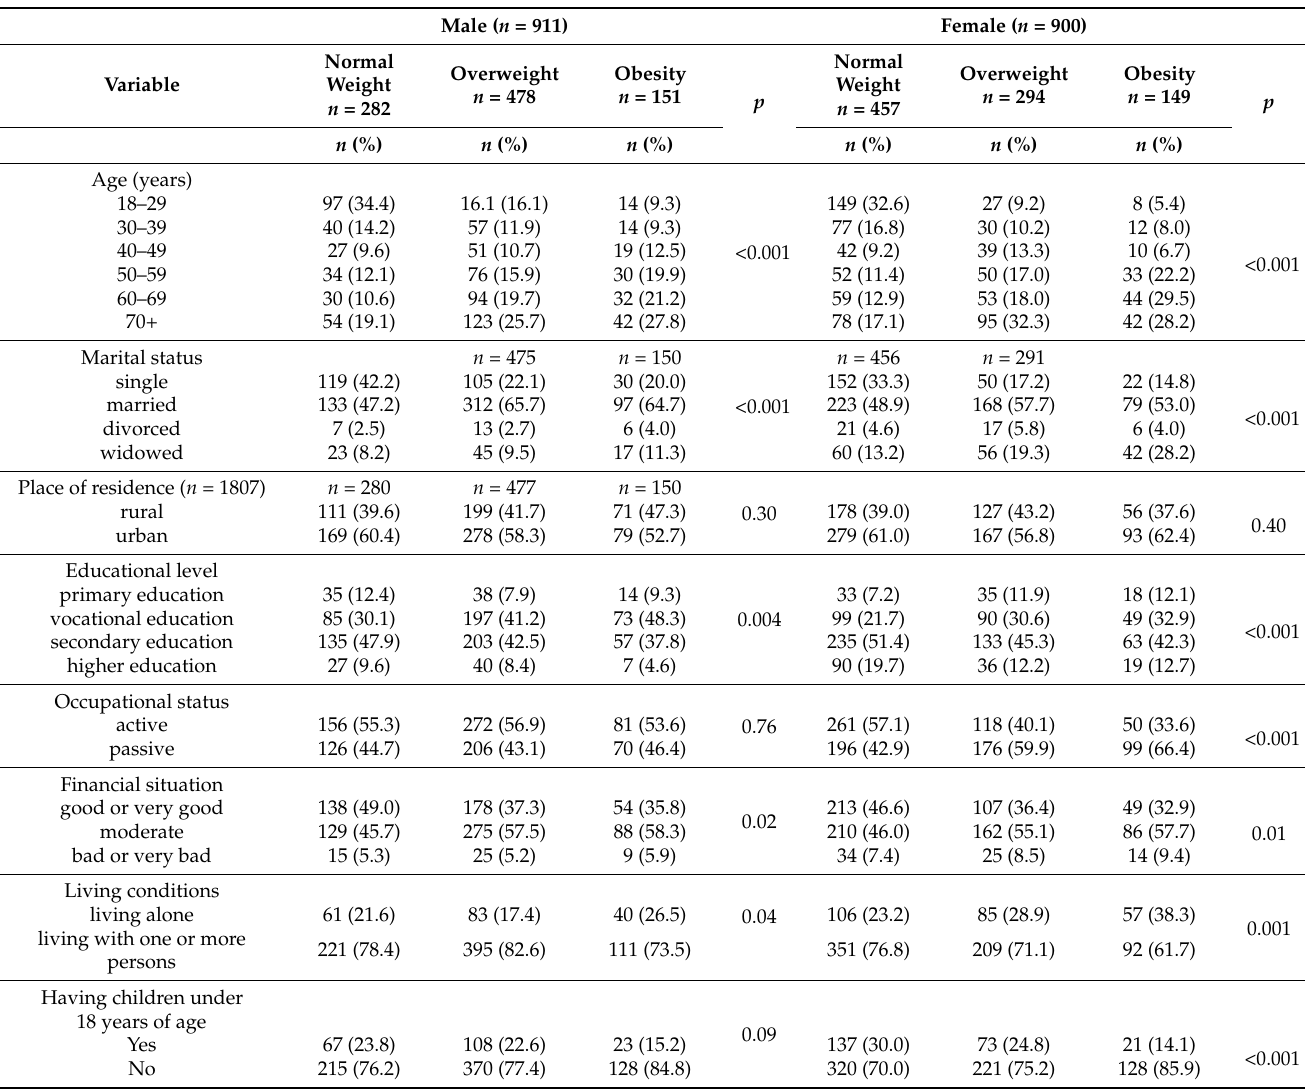
sociodemographic